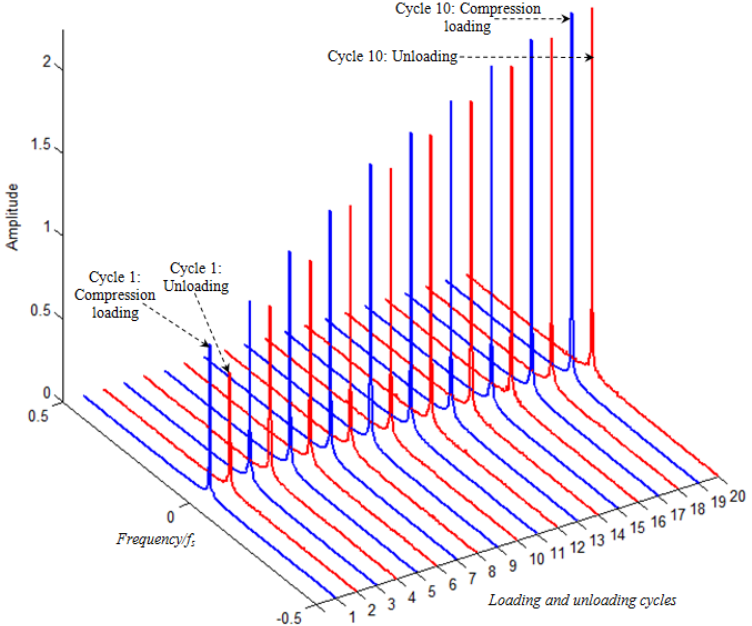
Figure 14. FFT analysis on (a) upper sensor signal during cycling loading and (b) lower sensor signal during cycling